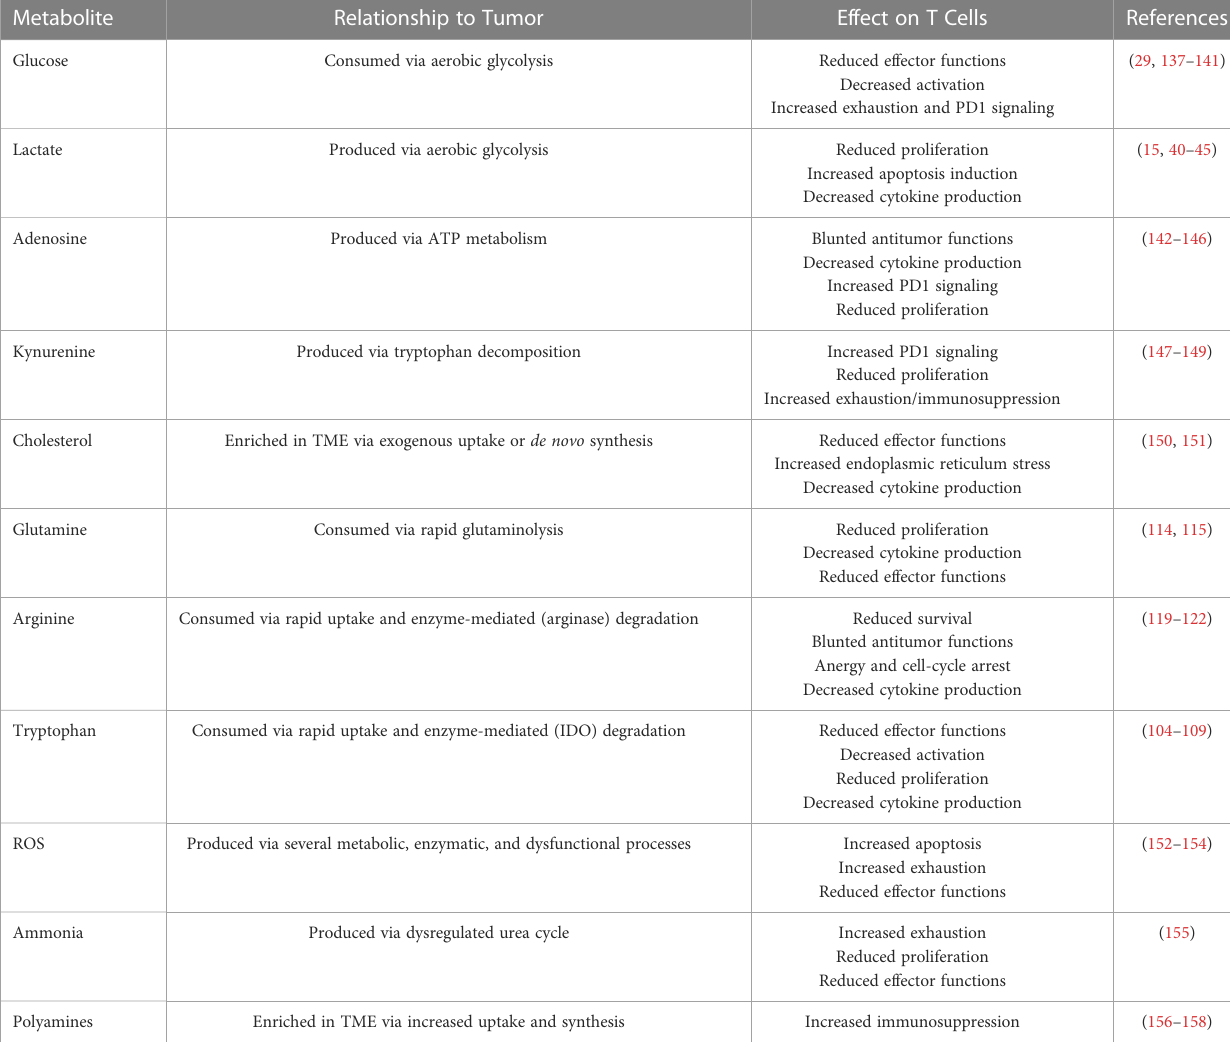
TABLE 1 Effects of select tumor microenvironment metabolites on T-cell